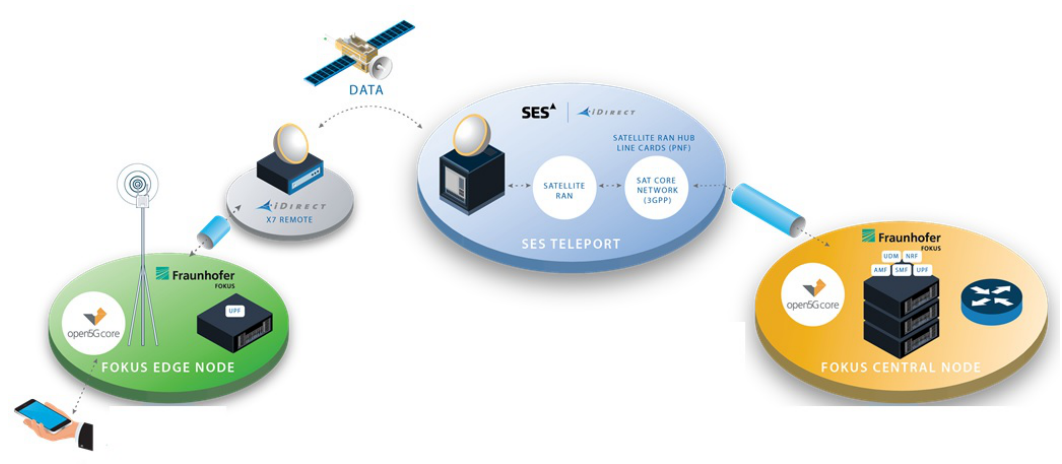
Figure 11. Seamless satellite integration into standard 3GPP network architecture (Setup